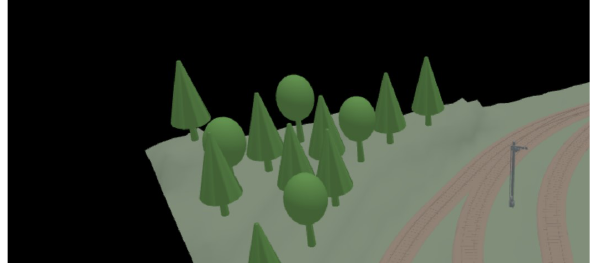
Figure 4. Trees rendering as GeometryTemplates from the railway.json dummy